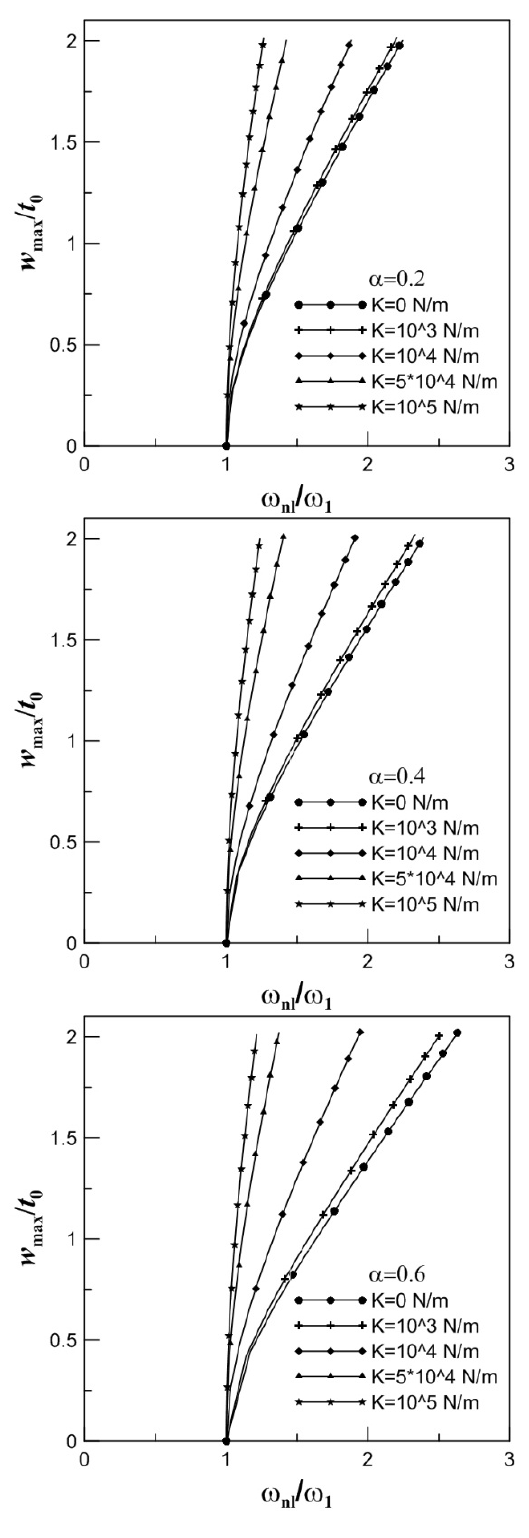
Figure 7: Backbone curve of AFG parabolic taper beam (︀ E ( ξ ) = E (︀ 1 + ξ + ξ 2 )︀)︀ on elastic 0 (1 + ξ ) , ρ ( ξ ) = ρ 0